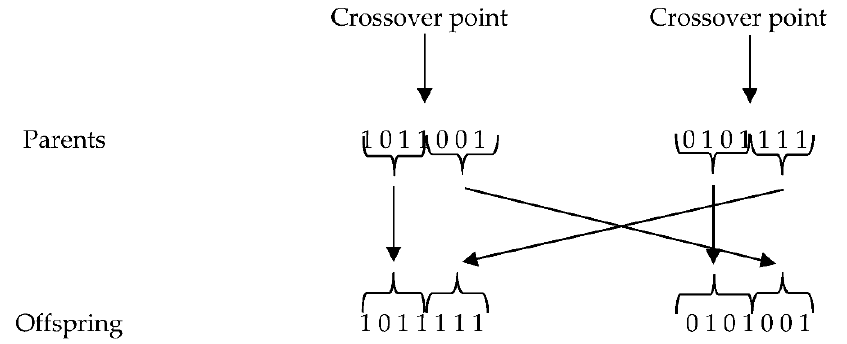
Figure A1. The scheme of a single-point crossover process of two 7-bit numbers.